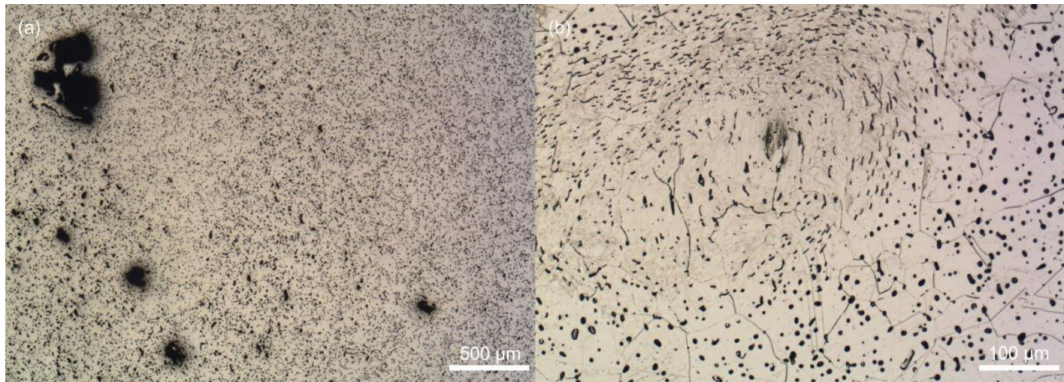
Figure 9. Microstructures of 316L stainless steel: ( a ) large defects on sintered area for 10 ◦ C / min speed; ( b ) vortexes located around larger pores at 15 ◦ C / min